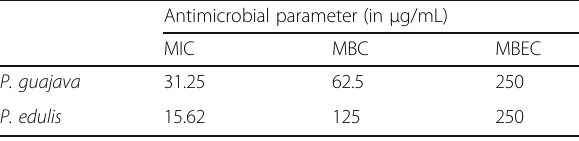
Table 3 Susceptibility of S. aureus isolates to the extracts and their interference on antimicrobial